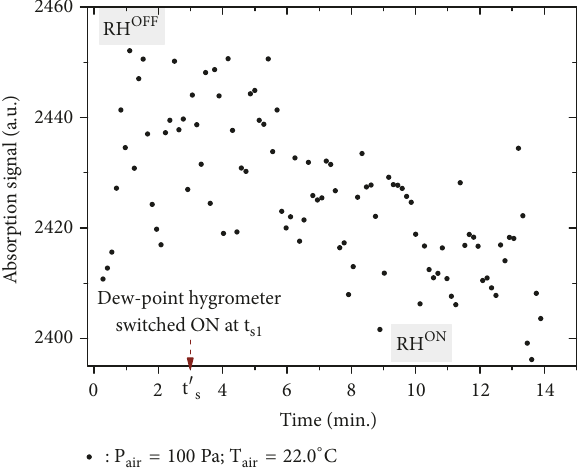
Figure 8: Absorption signal integrated over the absorption line of water vapor in 100 hPa air